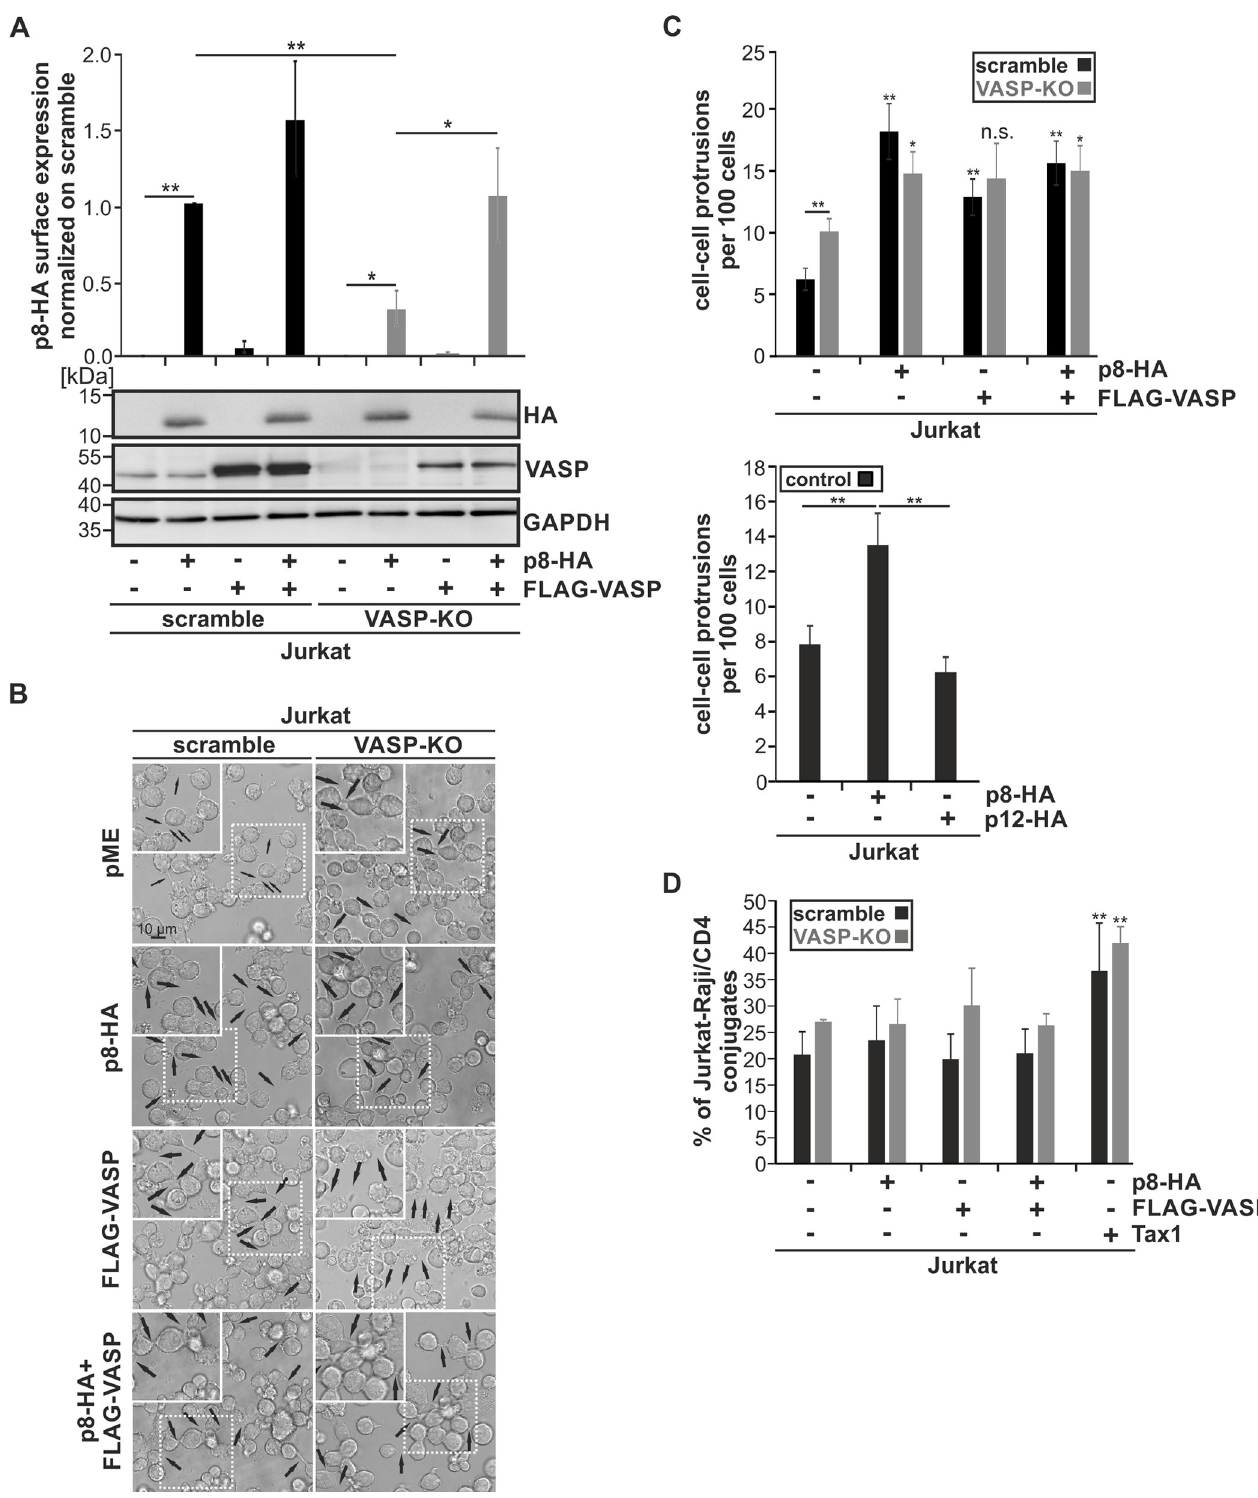
Fig 8. VASP is crucial for recruitment of p8 to the cell surface. (A-D) Jurkat scramble or Jurkat VASP-KO cells were transfected with p8-HA, FLAG-VASP or both plasmids. Cells transfected with empty vectors pME and pEF-1 α served as control. All samples were replenished with the respective empty vectors to 100 μ g. At 48 h post transfection, (A) p8 surface expression, (B-C) cell-cell-protrusion formation, or (D) cell-cell conjugate formation were analyzed in at least three independent experiments. In parallel, protein lysates were isolated and subjected to Western blot analysis. (A) Transfected Jurkat scramble (black bars)